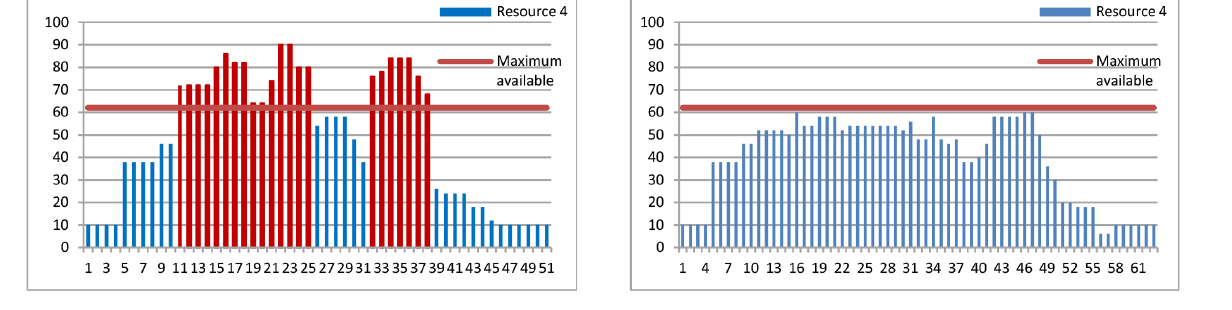
Figure 52. Daily usage of resource 4 throughout the calendar of the project (before using the method)-Experiment 3